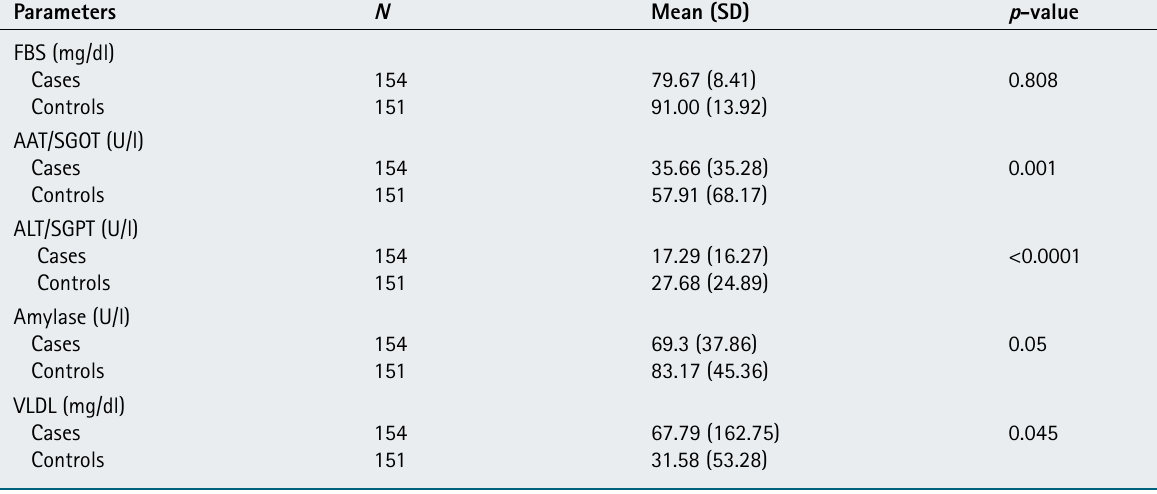
taBle iii. coMPariSon oF MeanS oF otHer BiocHeMical ParaMeterS oF caSeS v. controlS